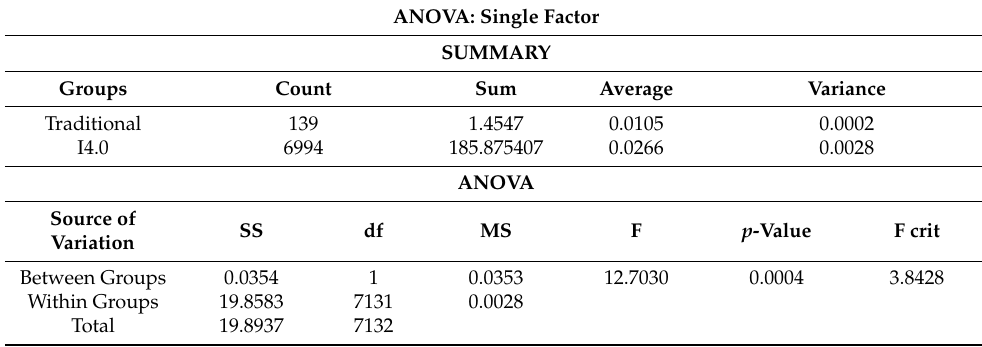
Table 9. ANOVA of probability of